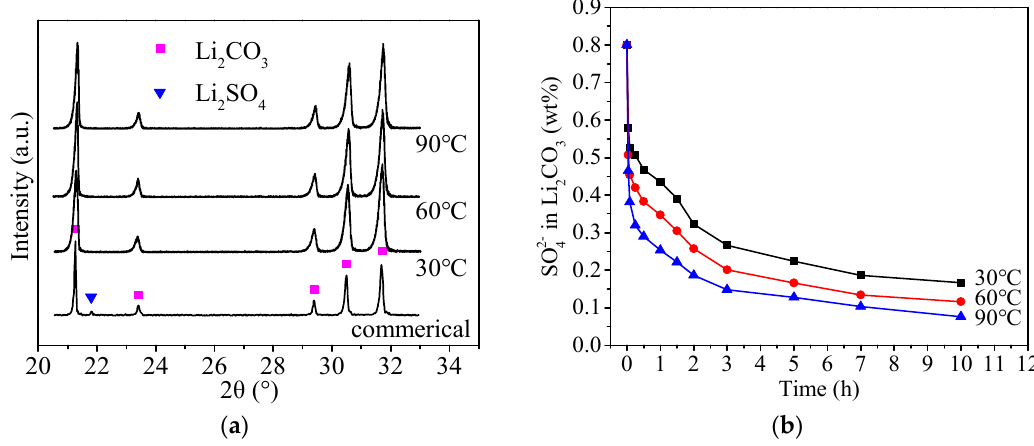
Figure 3. ( a ) XRD patterns of of Li 2 CO 3 samples before and after recrystallization in Na 2 CO 3 solution; ( b ) Variation of SO 42 − in Li 2 CO 3 sample after recrystallization with reaction time.